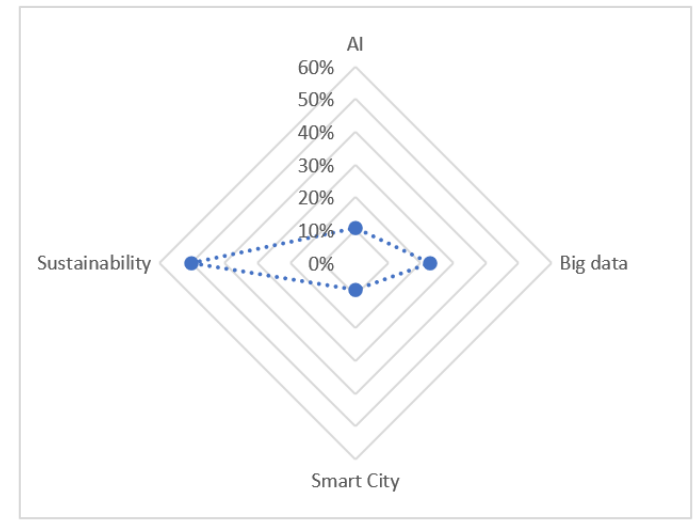
Figure 11. The demand on studied concepts knowledge within energy managers.